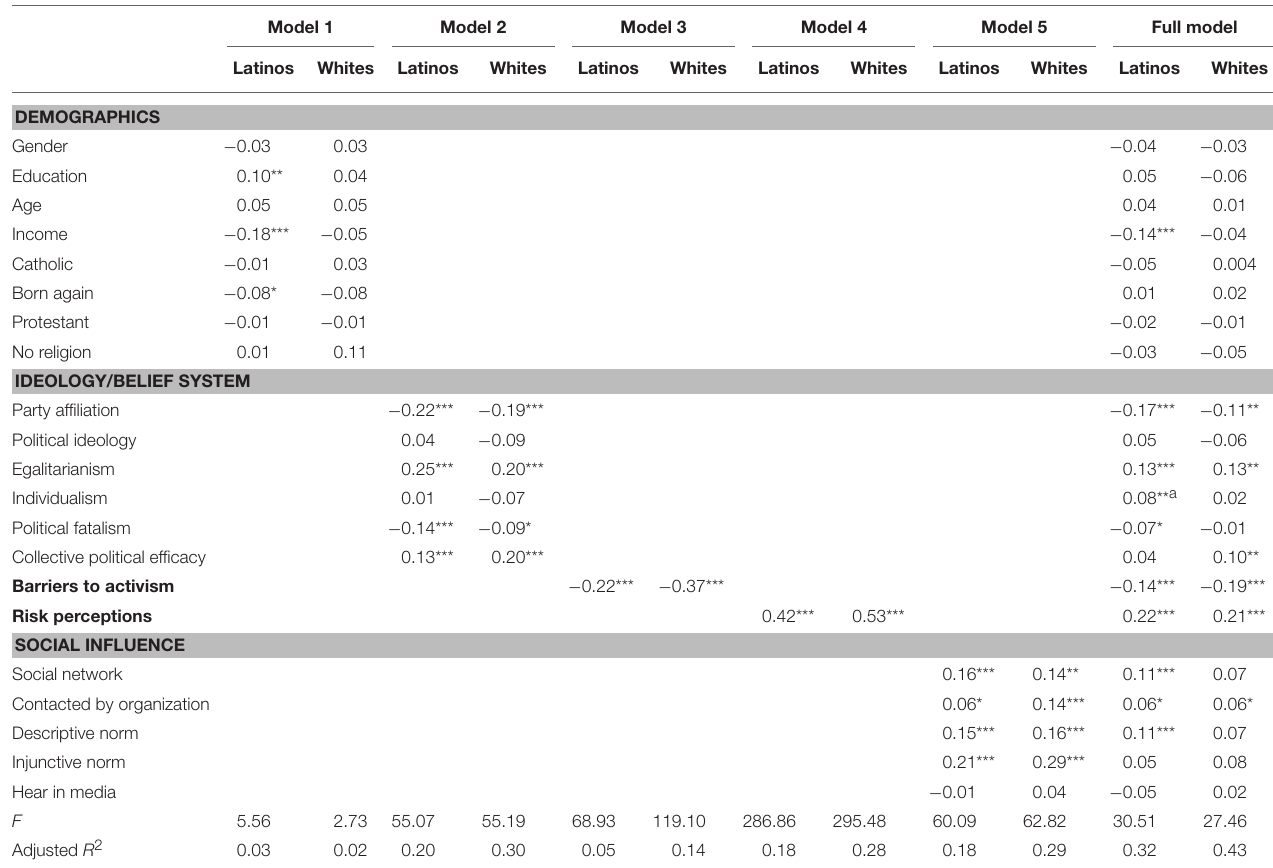
TABLE 2 | Predictors of intentions to contact government